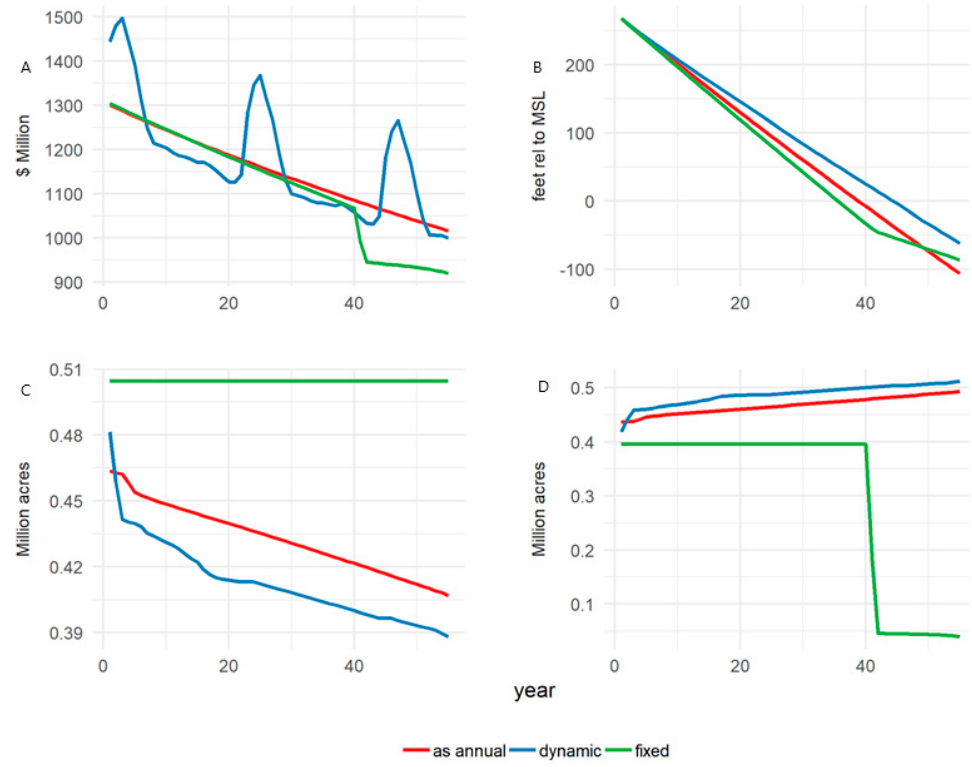
Figure 6. Model comparison of key series for the “low water” scenario. ( A ) annual net benefits, ( B ) aquifer height, ( C ) perennial area, and ( D ) annual area.